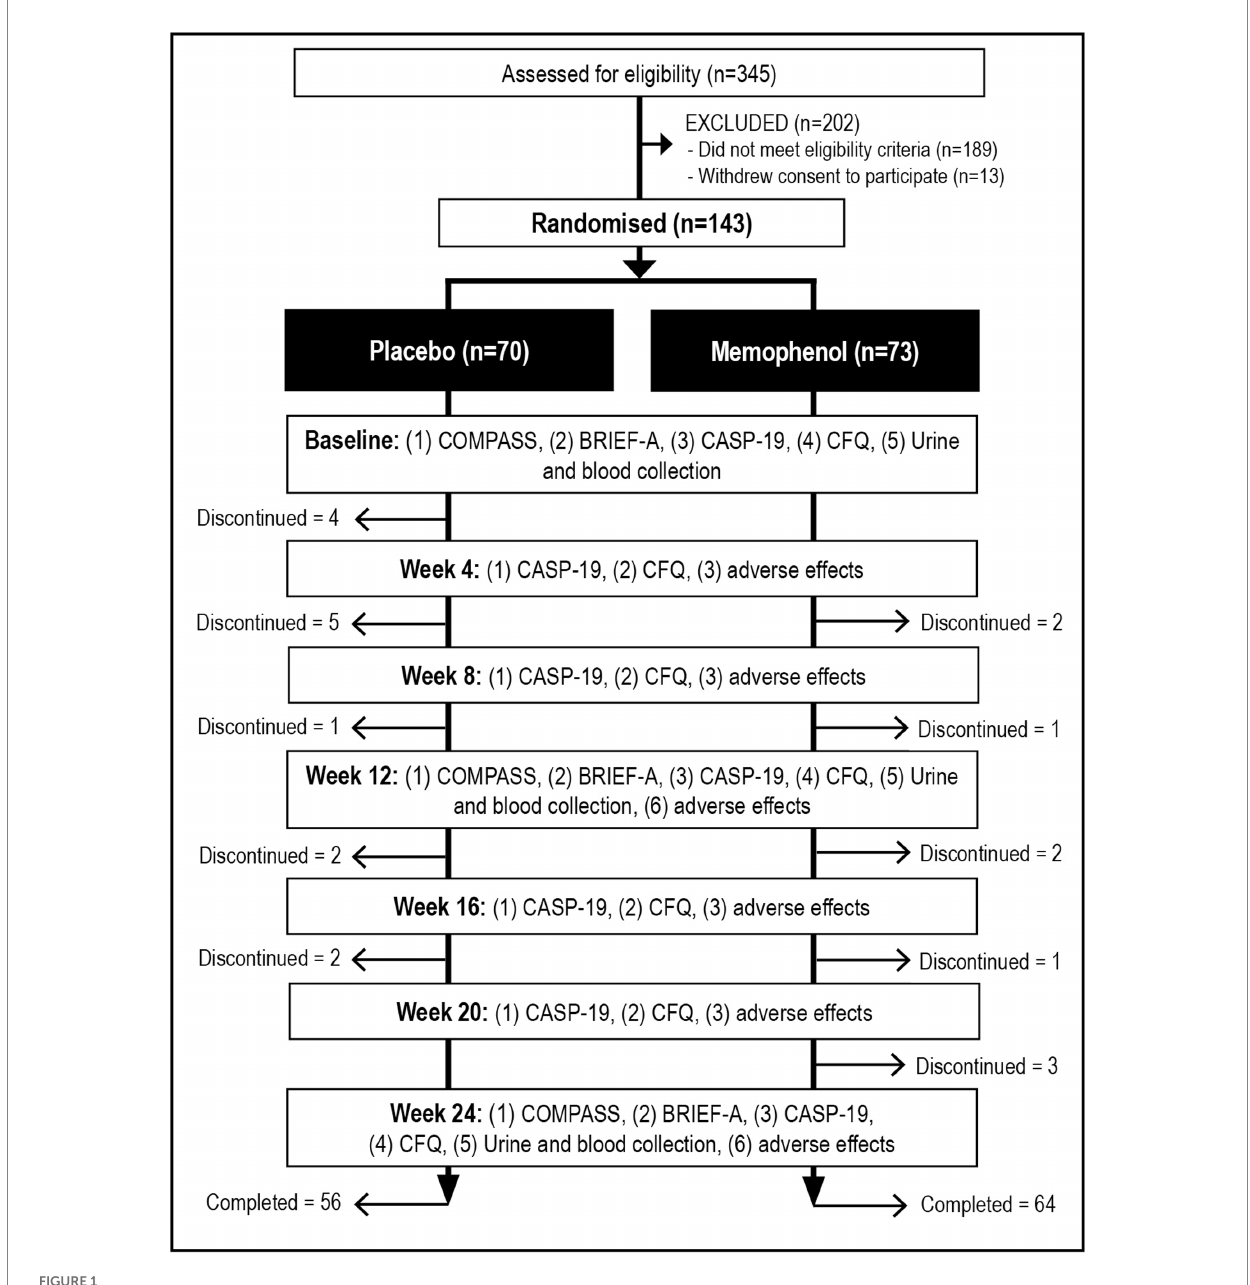
FIGURE 1 Systematic illustration of study